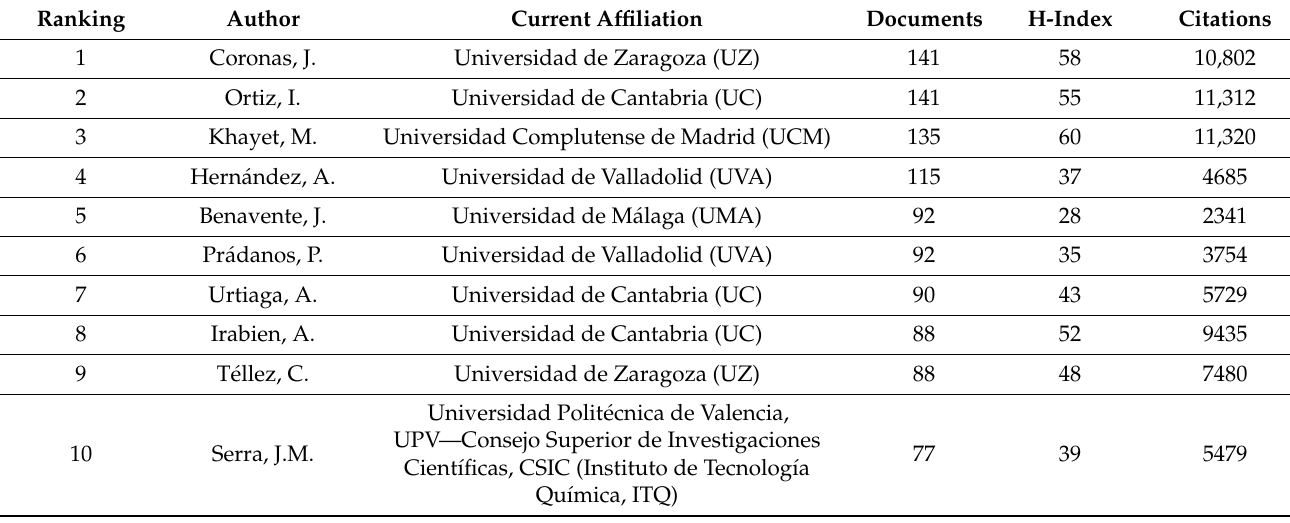
Table 4. List of 10 most prolific authors with their affiliation and relevance in the period 1960 ‐ 2021 90 analyzed the present non ‐ exhaustive overview performed in this work.